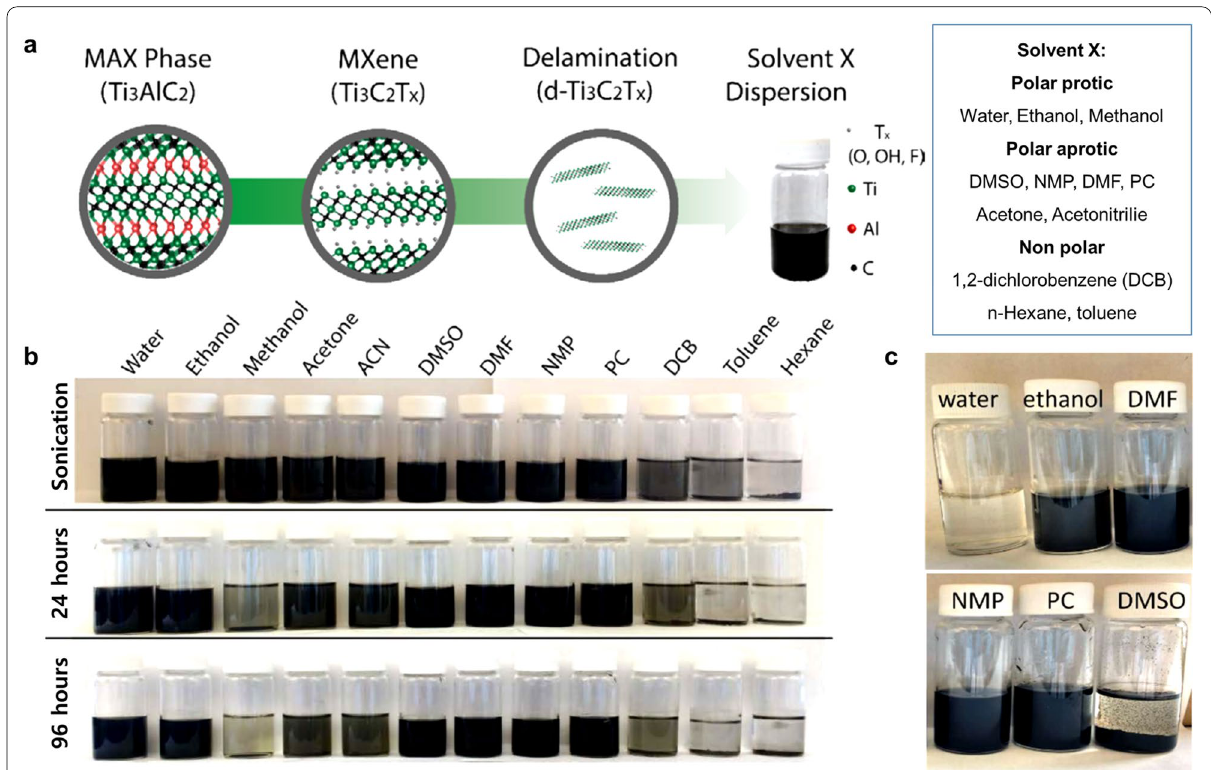
Fig. 9 a Schematic describing the synthesis and dispersion of Ti 3 C 2 T x in various organic solvents. b Dispersions of 50% HF-etched Ti 3 C 2 T x in the 12 different solvents. Time points of just after sonication (top), 24 h after sonication (middle), and 96 h after sonication (bottom) were used to monitor stability. c Long-term dispersion stability (after 40 days) of Ti 3 C 2 T x MXene in organic solvents and water. Ti 3 C 2 T x in water oxidized (white sediment) while the dispersions in ethanol, DMF, NMP, PC stayed dark in color. Ti 3 C 2 T x in DMSO agglomerated over time and formed a sediment but remained black (no visible oxidation). a – c Reproduced with permissions from ref. [39]. Copyright (2017), American Chemical